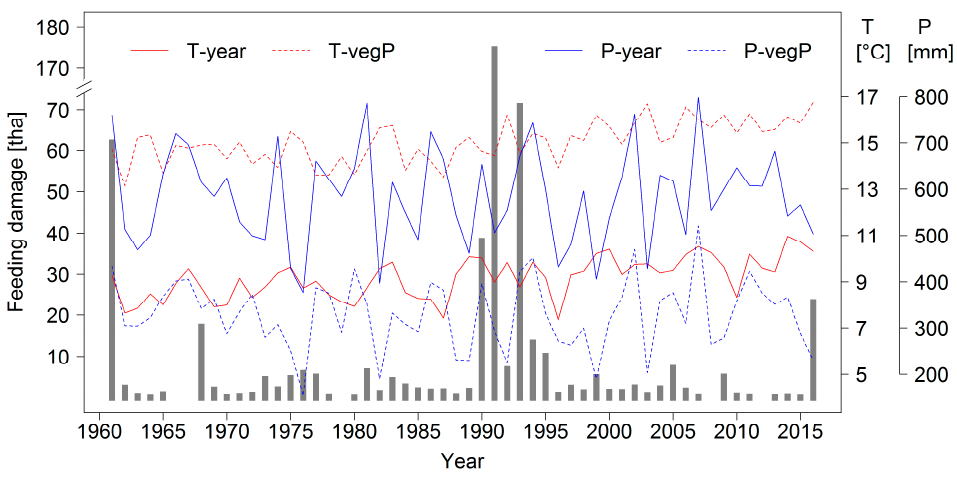
Figure 2. Forest area affected by feeding of Diprion pini larvae in the state of Brandenburg (hectares × 1000; columns) compared to mean temperature (T) and sum of precipitation (P) per year (solid lines) and per vegetation period (vegP; dotted lines) at the German Weather Service station Potsdam.